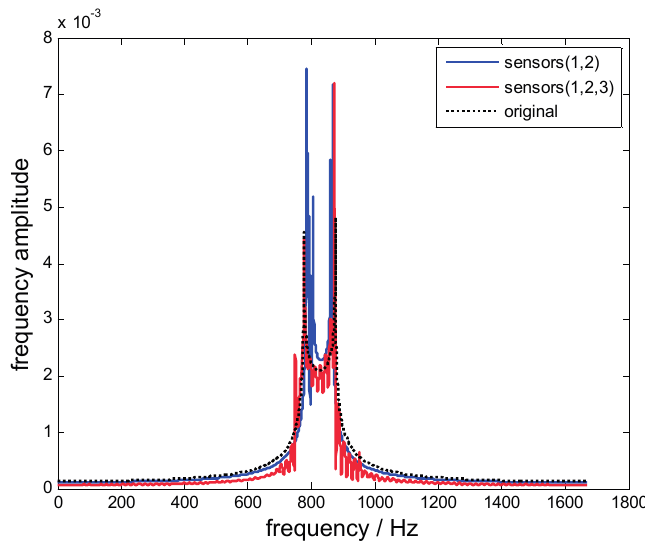
Figure 10. Frequency spectra of reconstructed signals and the original signal with B 0 = 100